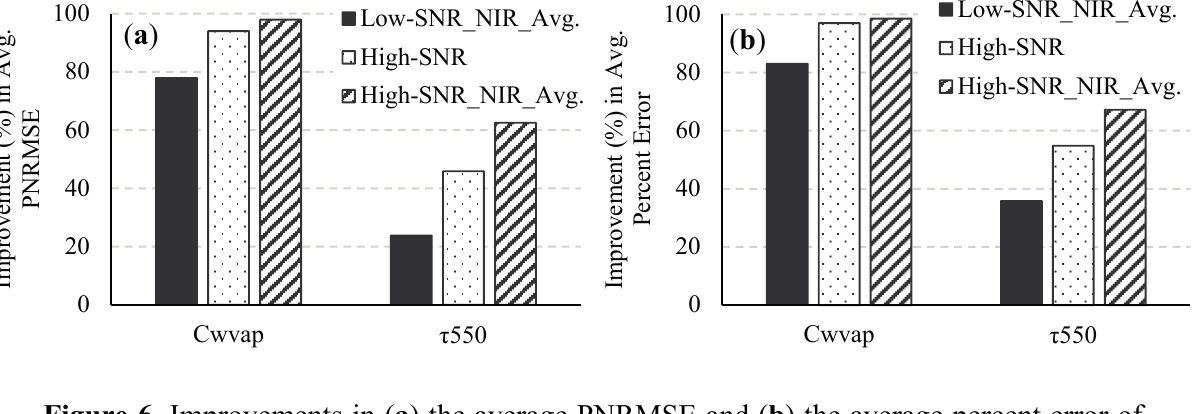
Figure 6. Improvements in ( a ) the average PNRMSE and ( b ) the average percent error of the retrieved C wvap and τ 550 for the low-SNR system with spatial averaging in the NIR spectral bands, the high-SNR system, and the high-SNR system with spatial averaging in the NIR spectral bands over what was obtained for the low-SNR system.